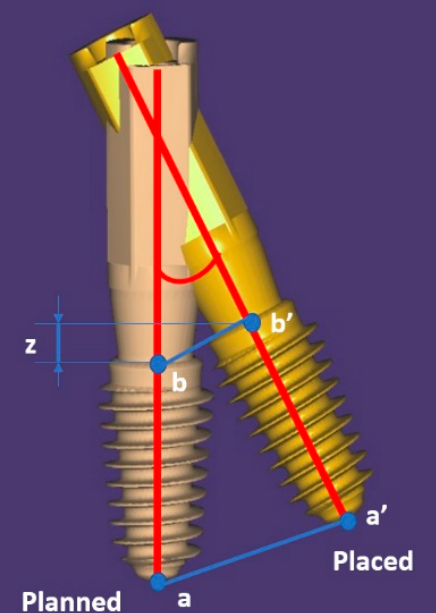
Figure 6. Trueness assessment was performed 3D at the implant entry point (b’ vs. b), at the implant apex (a’ vs. a), angular deviation between the axes of the planned and effectively placed implant, and vertical deviation on z axis.